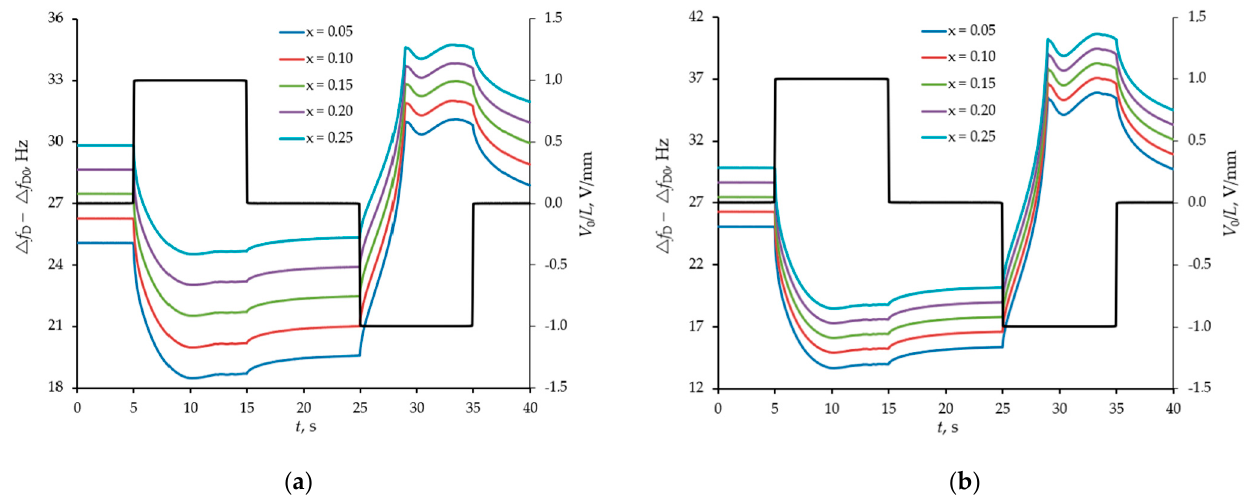
Figure 5. The difference response from two sensors (with smooth and structured surfaces) in the form of a shift of their resonance frequencies to manipulation of a model buffer solution with proteins by an external pulsed field at different content of globulin (x = /[Albumin], [Albumin] = 2 g/L) for pH = 6 ( a ) and pH = 9 ( b ). Frequency shifts (left axes) are shown with coloured curves, and pulse actions (right axes) are shown with a black broken line.